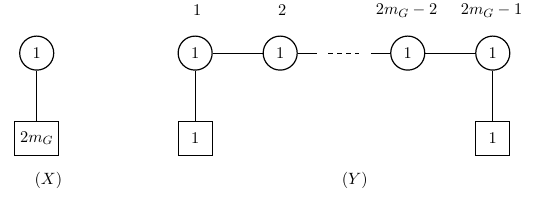
Figure 7 . A pair of mirror dual Abelian linear